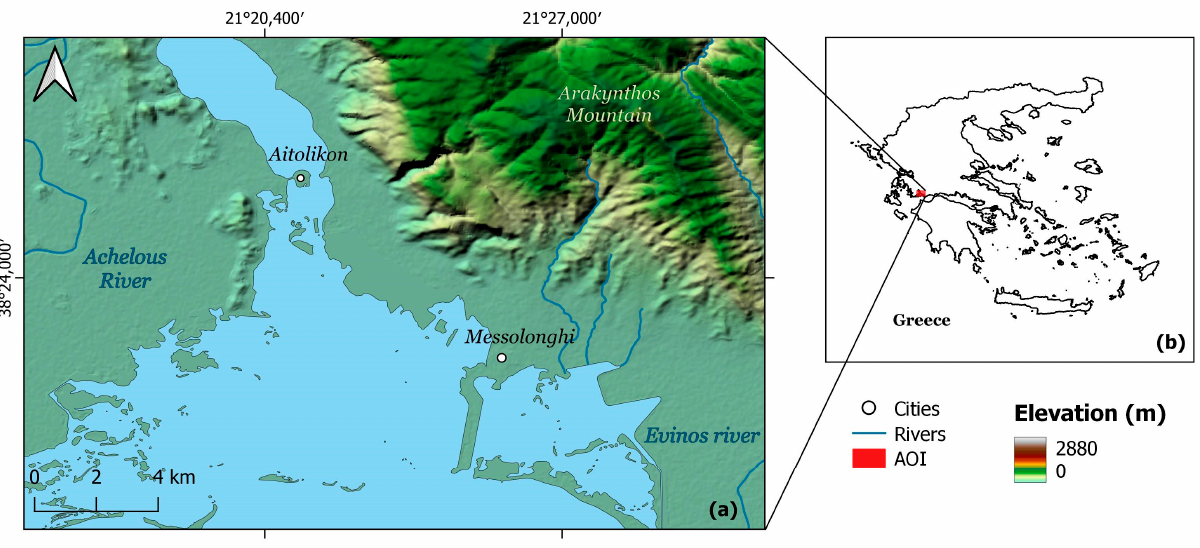
Figure 1. ( a ) The cities of Messolonghi and Aitolikon & ( b ) Location of study area.